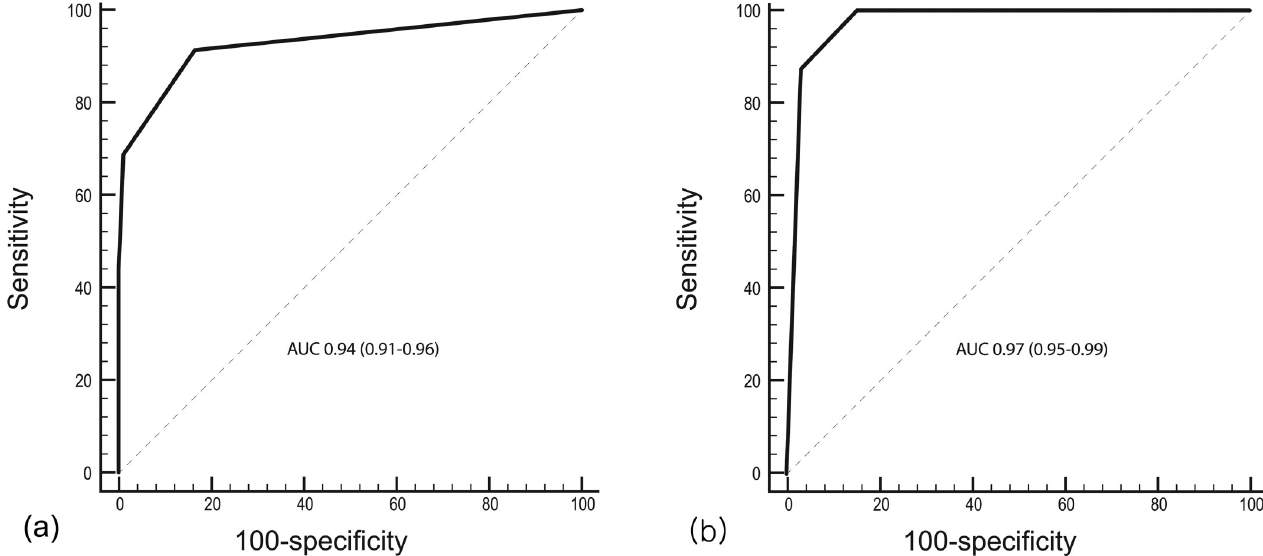
Fig 6. Receiver operating characteristic curves of the ranking system for arterial spin labeling (ASL) images, using either matched or mismatched perfusion defects (a) on dynamic susceptibility contrast (DSC) perfusion imaging or matched perfusion defects only (b) as the gold standard. The area under the curve (AUC) value was 0.94, and 0.97, respectively. Numbers within parentheses are 95% confidence